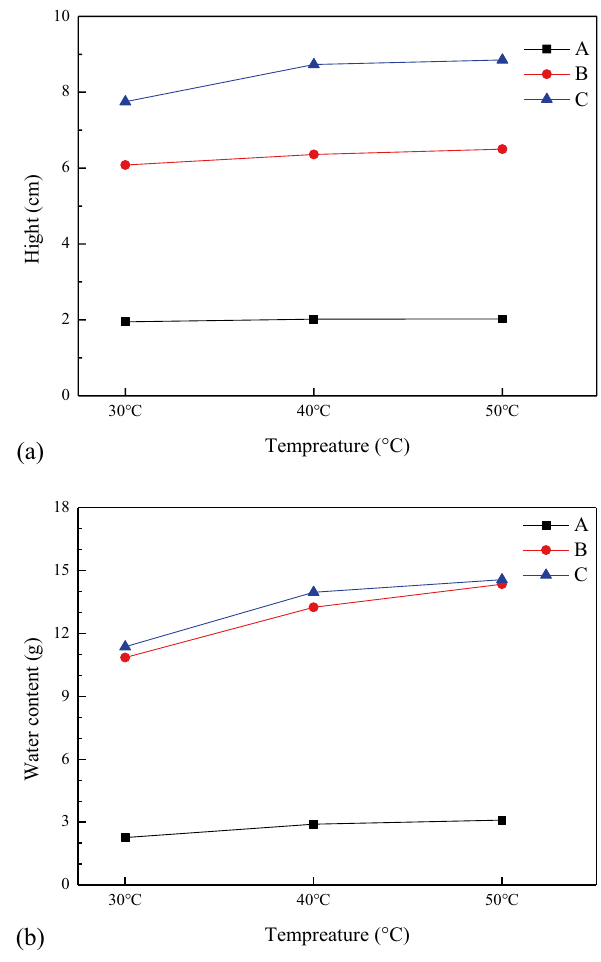
Figure 8. Influence of temperature on capillary rise height and water content.